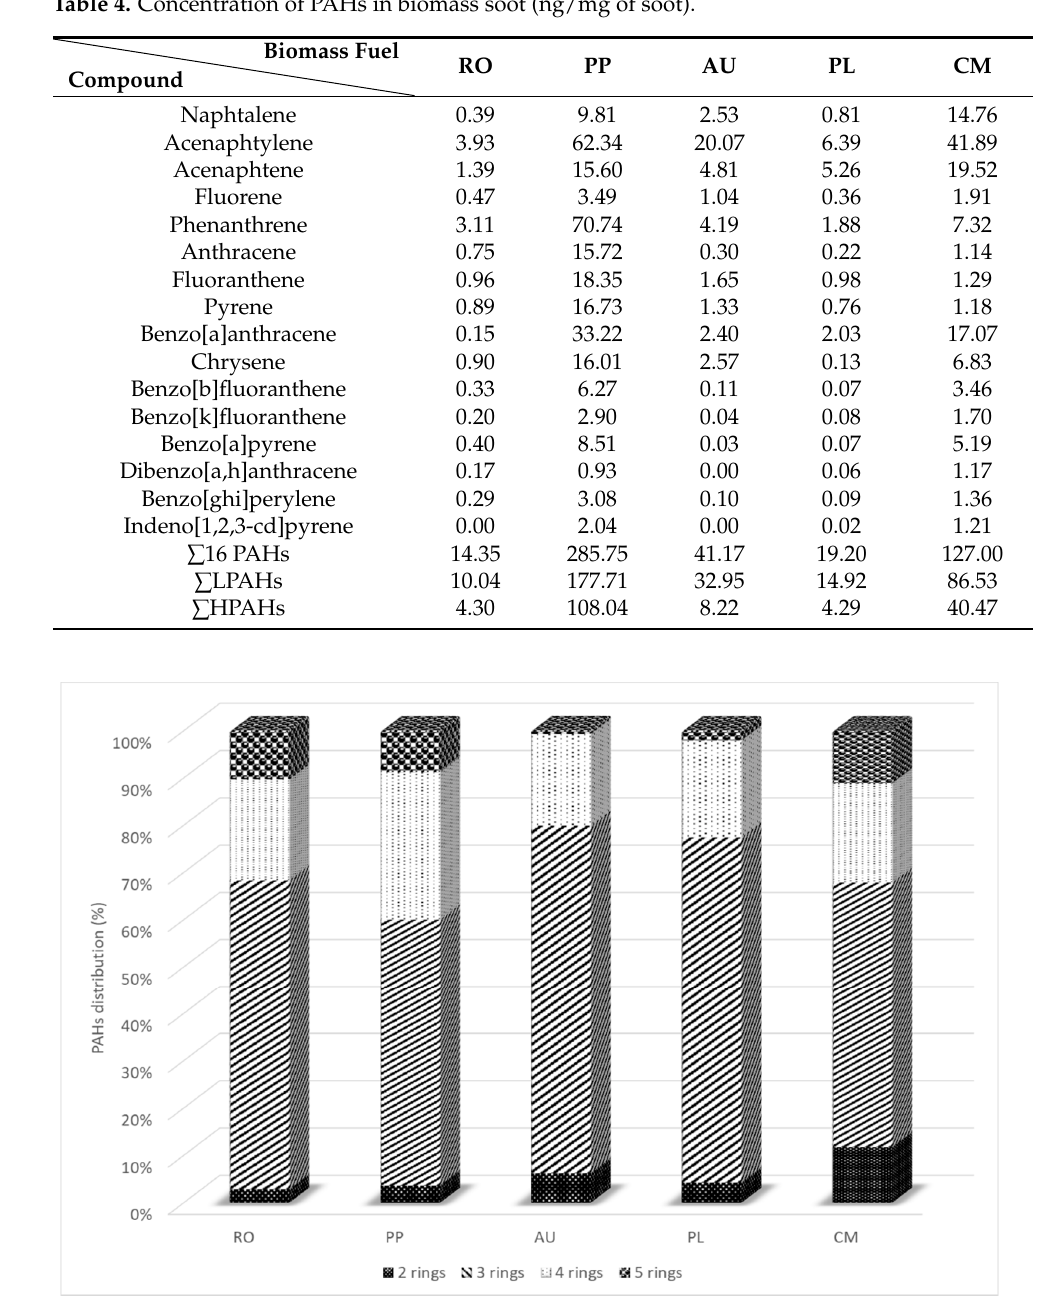
Figure 3. PAHs distribution for the 5 biomass fuels.